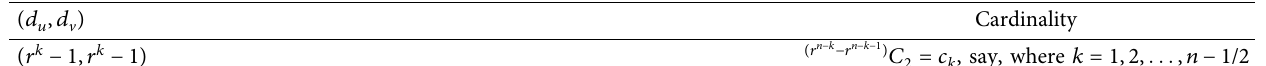
Table 14: Partition of pair of nodes ( u, v ) having distance